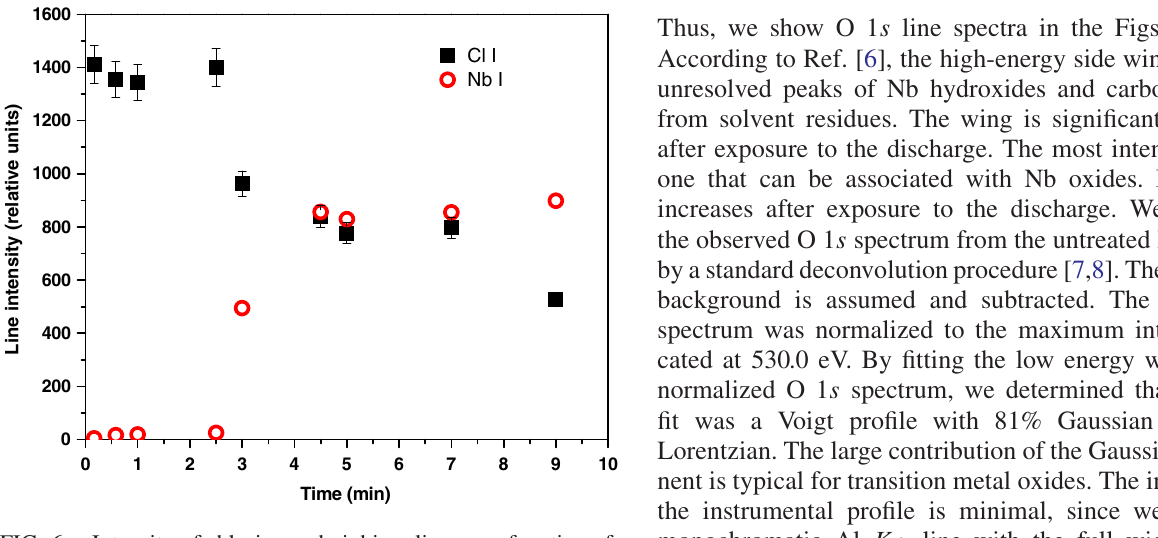
FIG. 6. Intensity of chlorine and niobium lines as a function of time. Data are taken during the etching process. The behavior is typical for all lines. Statistical errors are